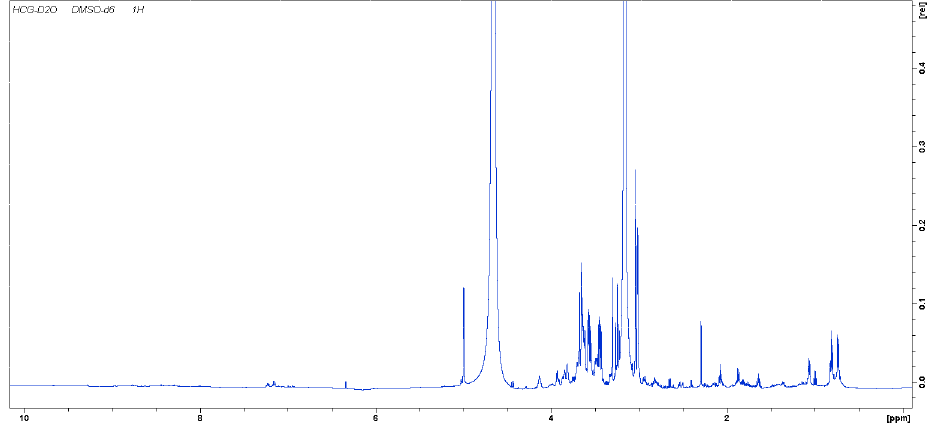
Figure A1. Analysis of the 1 H NMR of water fraction.